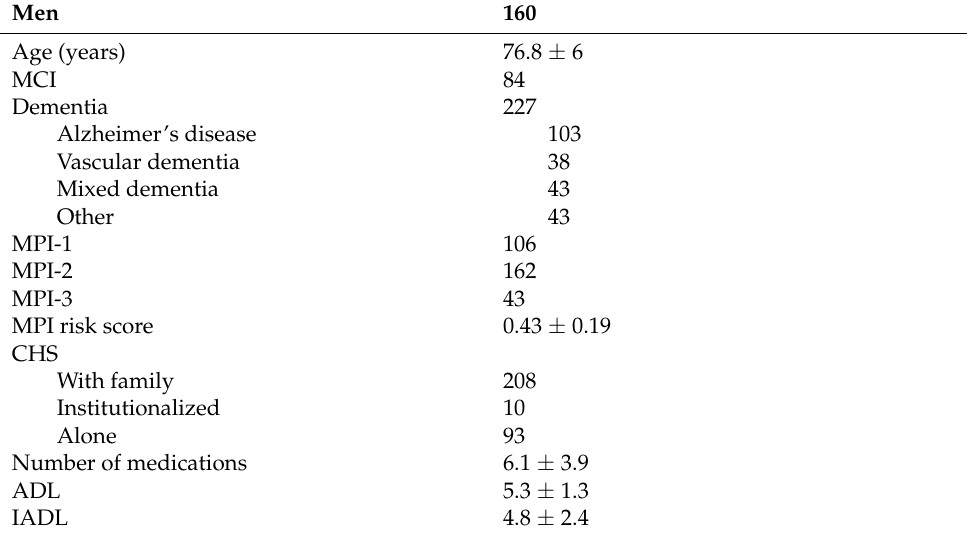
Table 2. General characteristics ( n = 311).